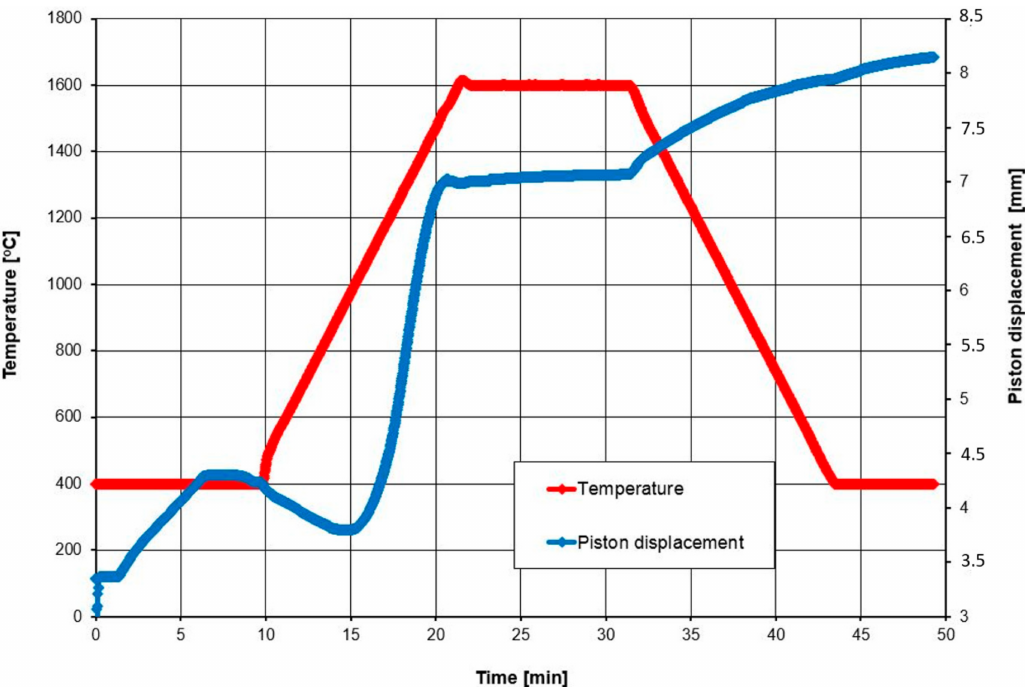
Figure 3. Sintering curve of alumina-zirconia powder with Ti(C 0.5 ,N 0.5 ) n .